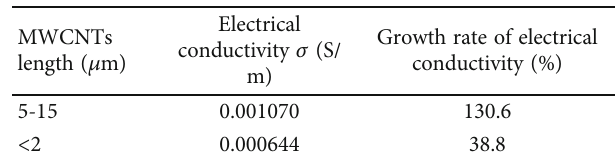
Figure 2: Testing method of electrical conductivity. Table 5: Electrical conductivity and growth rate of cement mortar with di ff erent lengths of